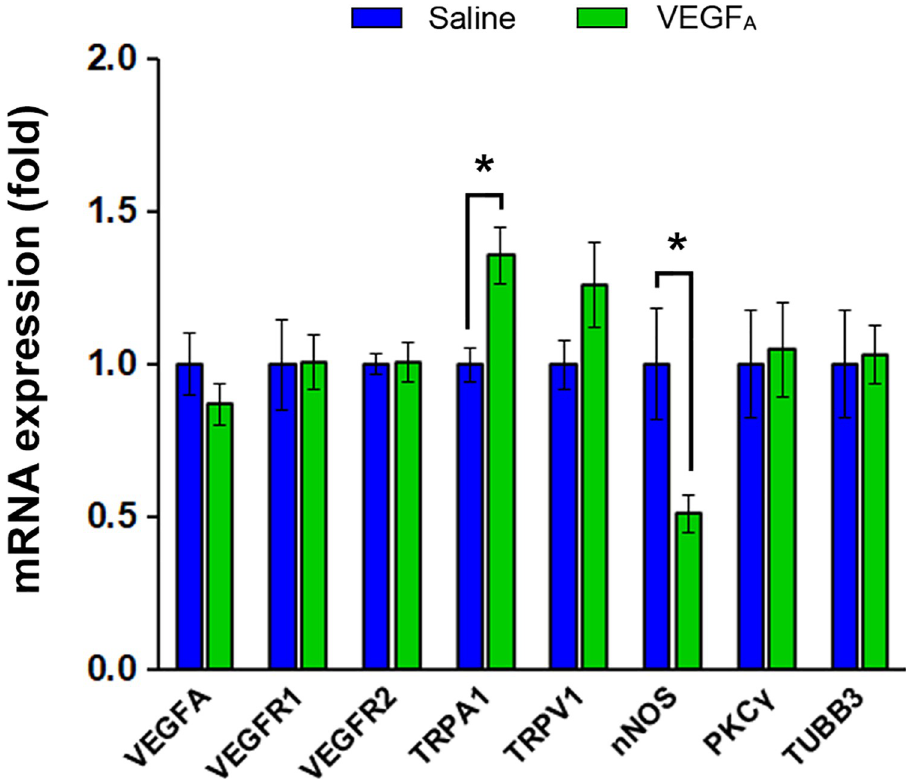
Fig 4. Bladder VEGF A instillations caused changes in mRNA expression in TRPA1 and nNOS genes in lumbosacral DRG. Significantly higher TRPA1 mRNA expression and lower nNOS mRNA expression were detected in lumbosacral DRG isolated from VEGF A -instilled mice when compared to saline-instilled mice. No differences were detected in the gene expression of either VEGF receptors.